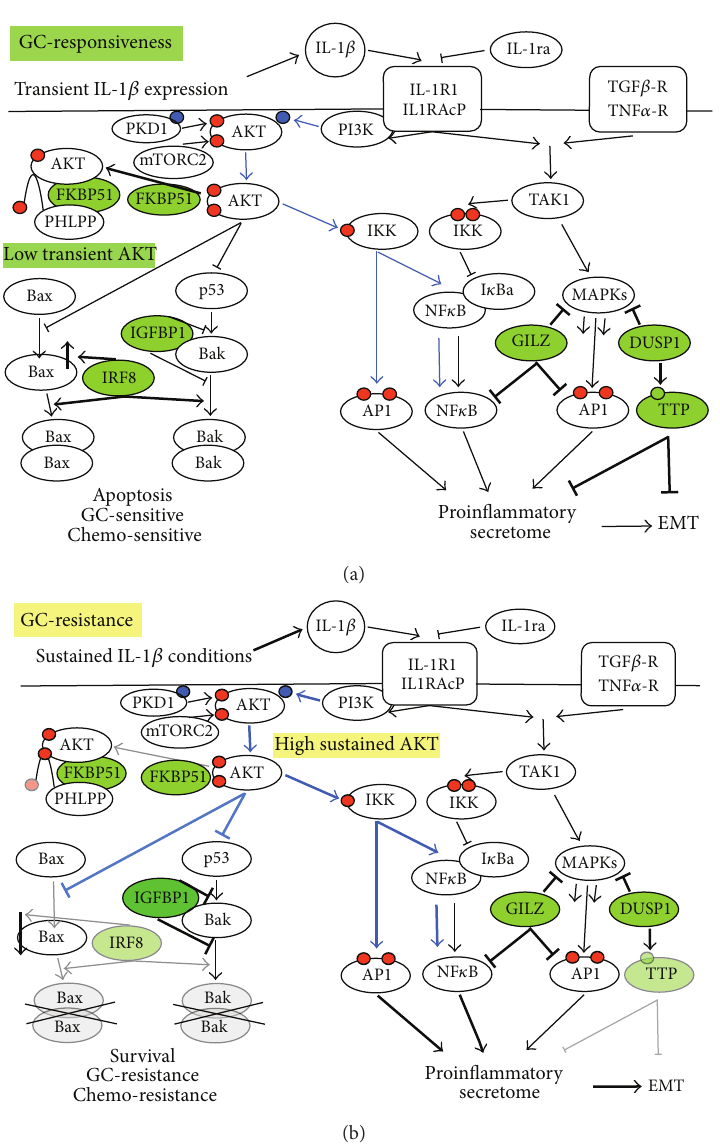
Figure 6: IL-1R1 signal transduction and negative regulation of GR-induced genes with known functions in inflammation and apoptosis: evidence of split GCR under sustained IL-1 𝛽 conditions and proposed association with chemo- and GC-resistance phenotypes and EMT. (a) Signaling through the TAK1 and AKT parallel transduction nodes under normal IL-1R1 signaling conditions [44]. In the right node, TAK1 activates the three MAPK signaling cascades, including the JNK-AP1 pathway and the classical NF 𝜅 B pathway. In the left node, AKT transiently promotes survival by inhibiting p53 and Bak/Bax-mediated apoptosis (thin black inhibition arrows) and also triggers a separate NF- 𝜅 B/AP1 activation pathway (thin blue arrows) [47]. The schematic superimposes the most prominent effects mediated by the 6 selected GC-inducible genes (FKBP51, GILZ, DUSP1, TTP, IRF8, and IGFBP1, highlighted in green) in the regulation of IL-1R1 signaling under noninflammatory conditions. The level of wild-type FKBP51 contributes to low transient AKT activity, while IRF8 increases Bax expression and Bax/Bak pathway activities (bold arrows) which counteracts the AKT and IGFBP1 upstream survival regulation. GILZ, DUSP1, and TTP exert their regulatory functions as indicated by the bold inhibition arrows [2, 47–56]. (b) Under sustained IL-1 𝛽 conditions, GC-driven transcription of FKBP51 is significantly reduced, which allows sustained AKT signaling (bold blue lines), which in turn has been associated with apoptosis- and chemo- and GC-resistance [52, 57]. IRF8 knockdown (in faded green) would reinforce the antiapoptotic AKT effects due to lower Bax expression and weak inhibition of other activities in the same pathway that lead to Bax-Bax pore formation (faded gray arrows) [55, 56]. The IGFBP1 overexpression would reinforce the antiapoptotic effects of AKT by further inhibiting activities that lead to Bak-Bak pore oligomerization [58] in the alternative pathway (faded and crossed-out). While GILZ and DUSP1 expression is unaffected in the IL-1 𝛽 -induced split GCR model, sustained AKT activation might still reinforce the expression of the proinflammatory secretome via the noncanonical NF- 𝜅 B/AP1 pathway (bold blue arrows) [47]. The latter might be potentiated by the reduction in TTP expression (2/3 less), a knockdown that has been also associated with EMT [54,